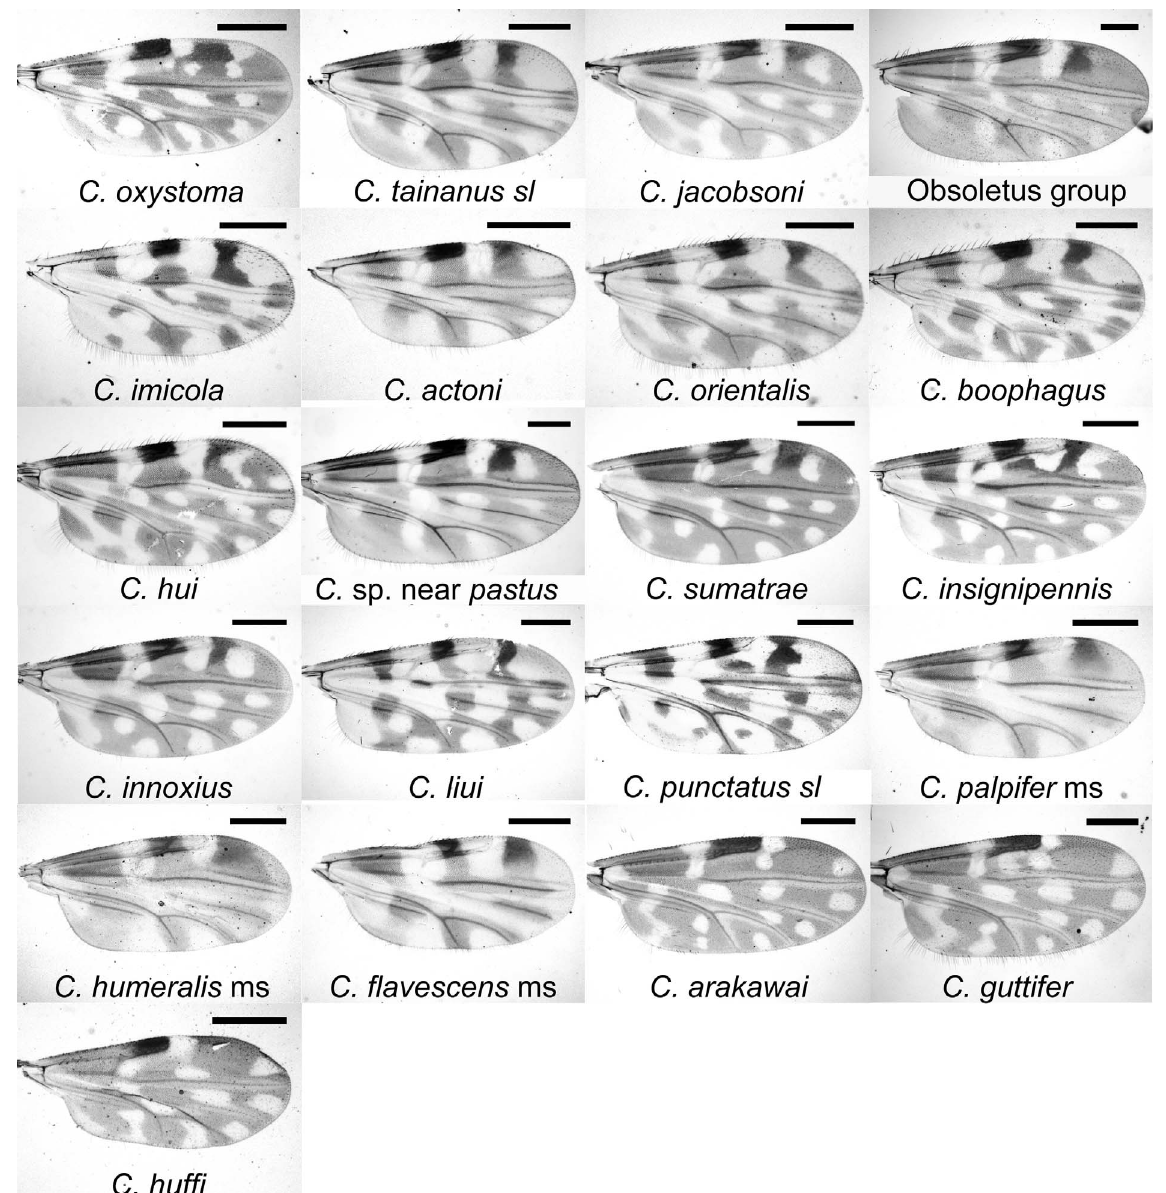
Figure 2. Photographs of representative female wings of the 21 Culicoides species collected at Wulong, Shizong County, Yunnan Province, China. Scale bar length = 250 l